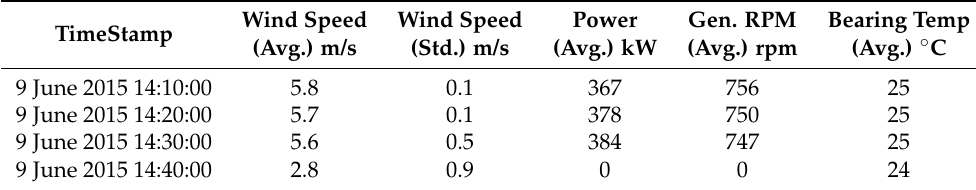
Table 1. Ten-minute SCADA data. Wind Speed Wind Speed Power Gen. RPM Bearing Temp TimeStamp (Avg.) m/s (Std.) m/s (Avg.) kW (Avg.) rpm (Avg.) ◦